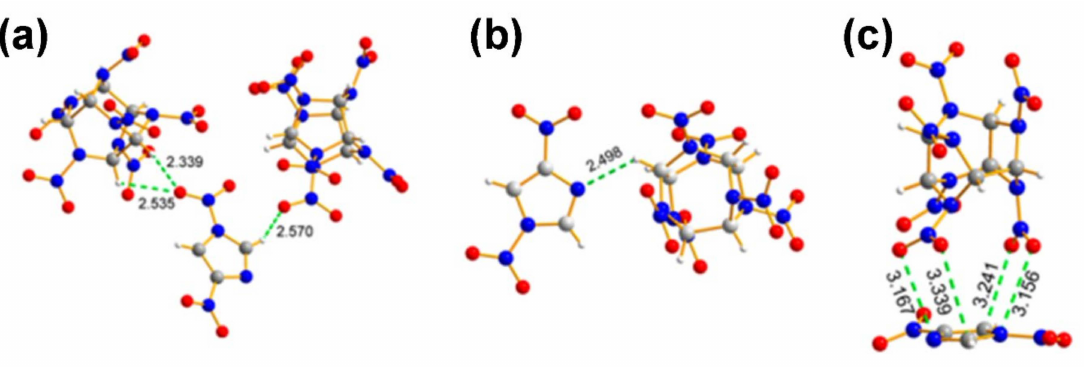
Figure 4. ( a ) CH ··· O hydrogen-bonding interactions. ( b ) CH ··· N hydrogen-bonding interactions. ( c ) NO 2 − π interactions. Reproduced from [56]. Copyright 2019, American Chemical